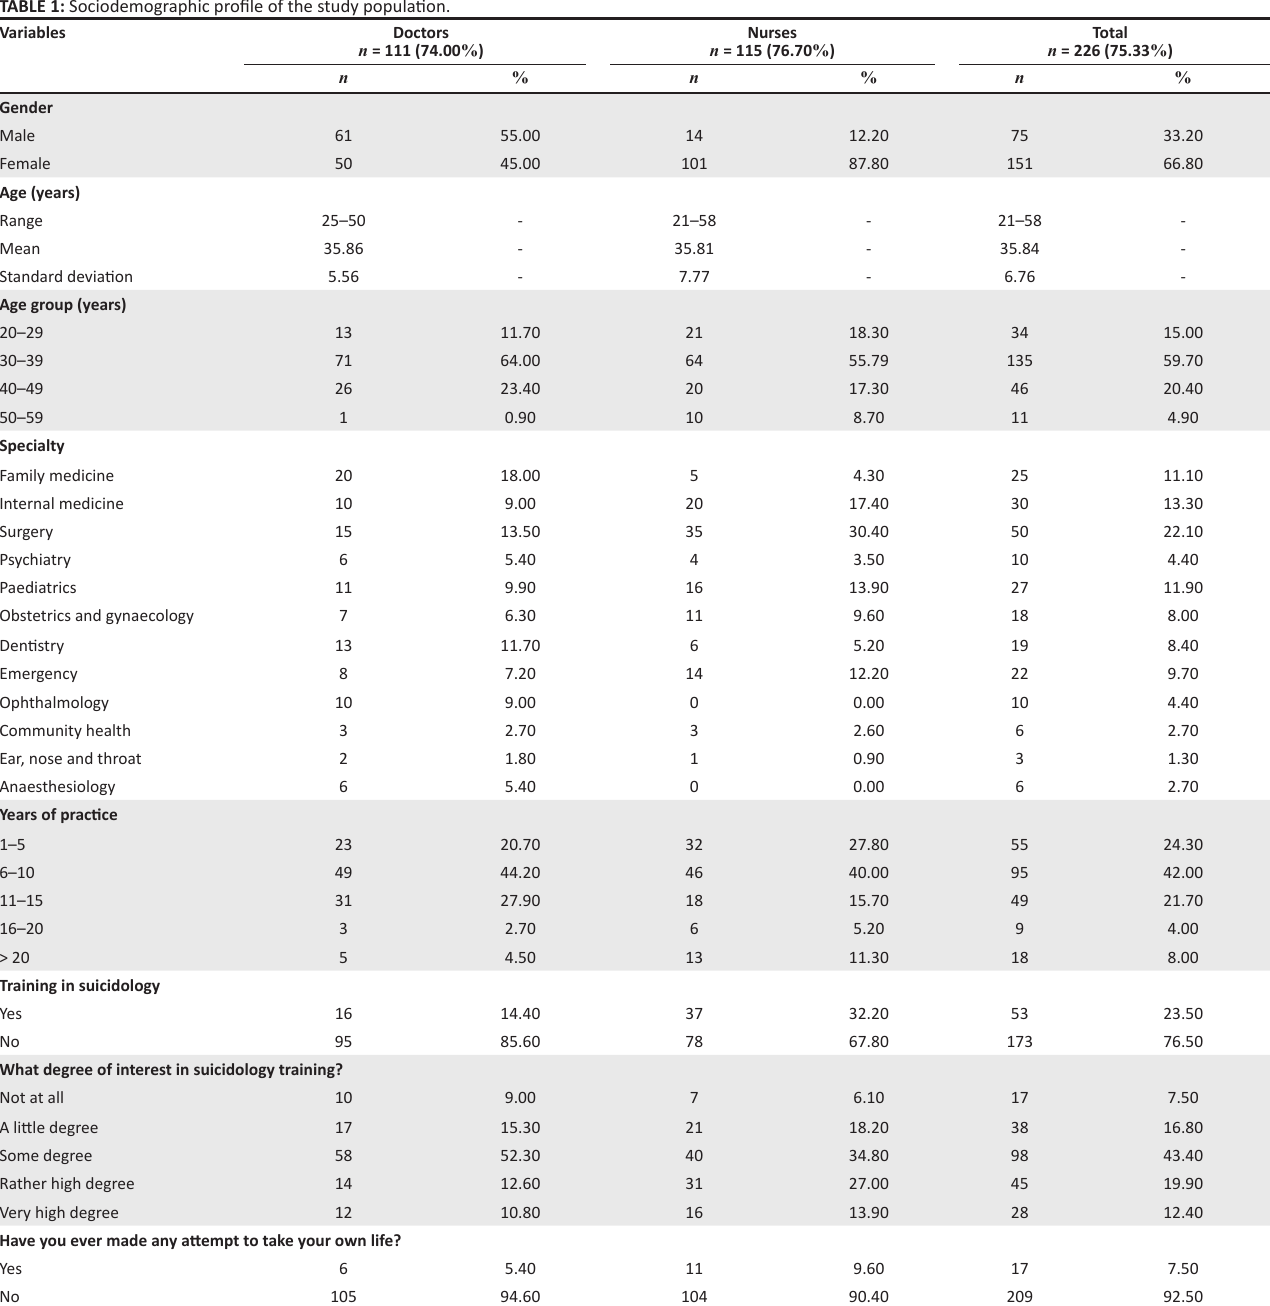
TABLE 1: Sociodemographic profile of the study population.